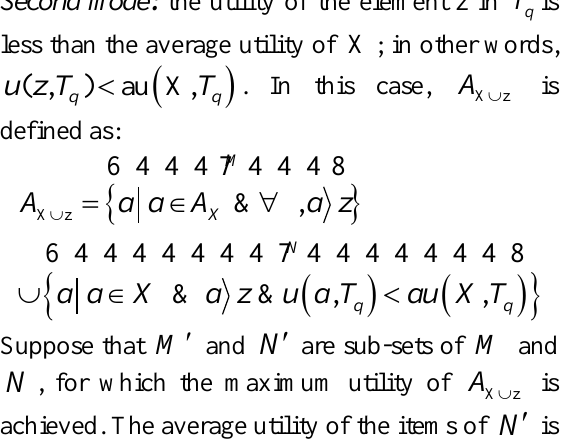
Figure 4. Search space base on the modified database in Table 5.